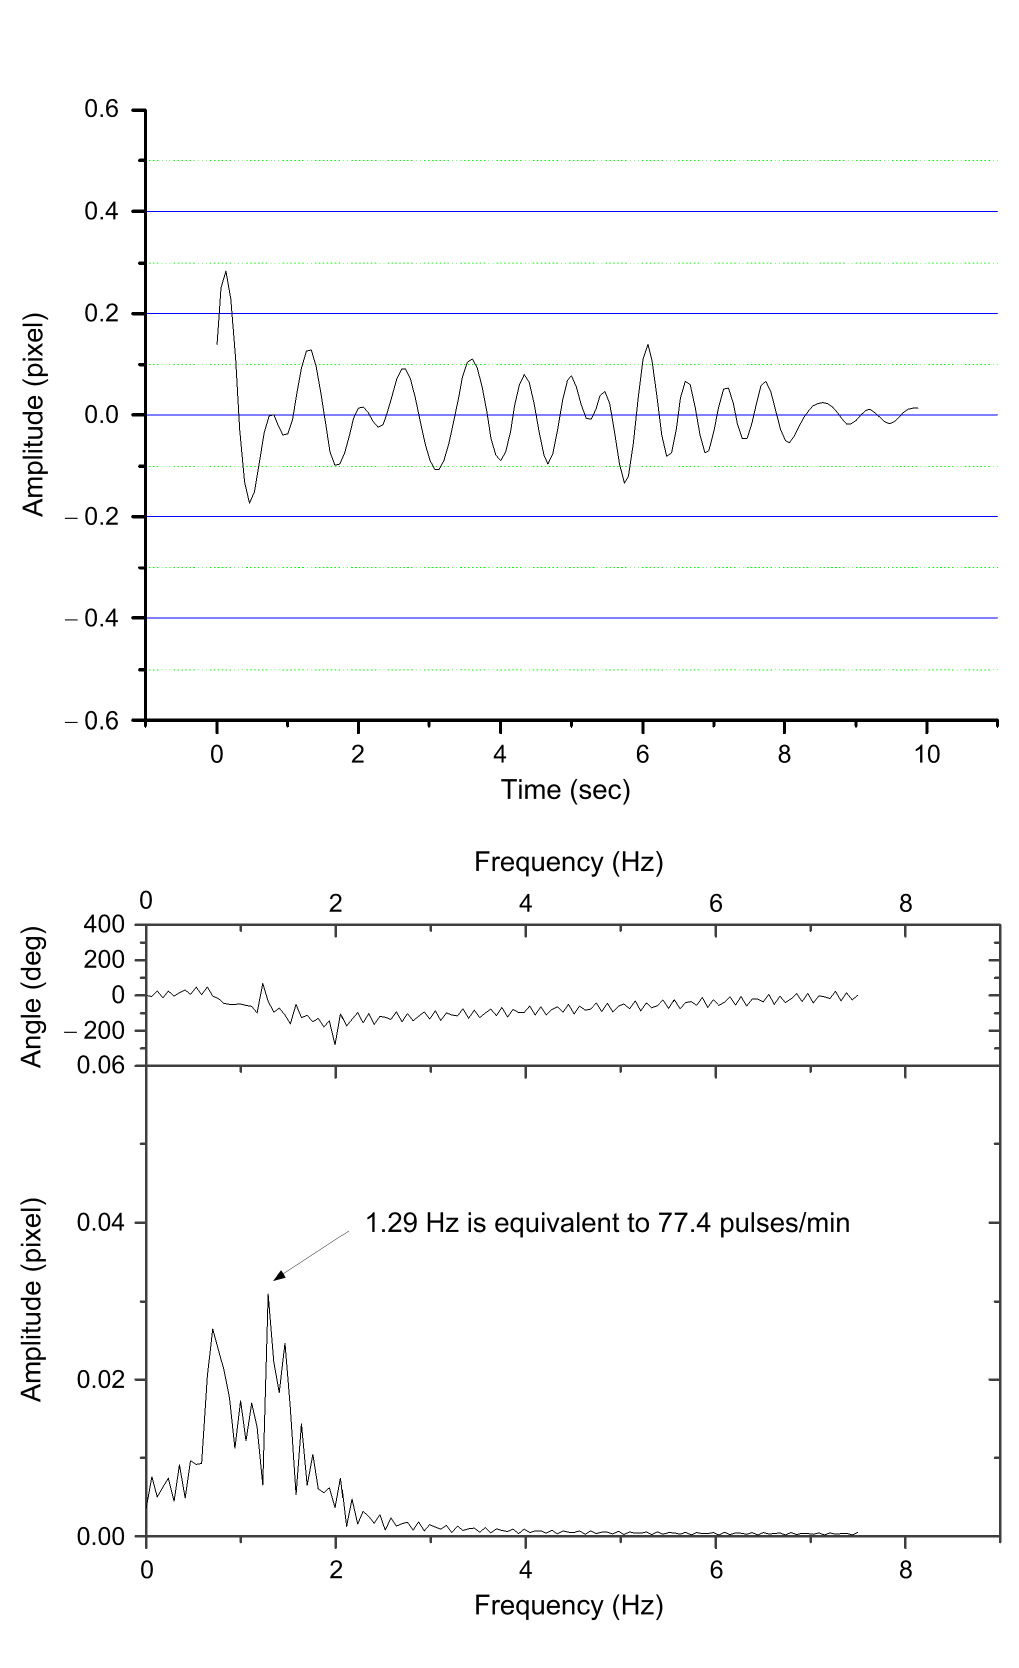
Figure 12. Pulse information measured at the Chun point on the left hand (small intestine) of the tested subject ( continued ): (b) 30 min after a